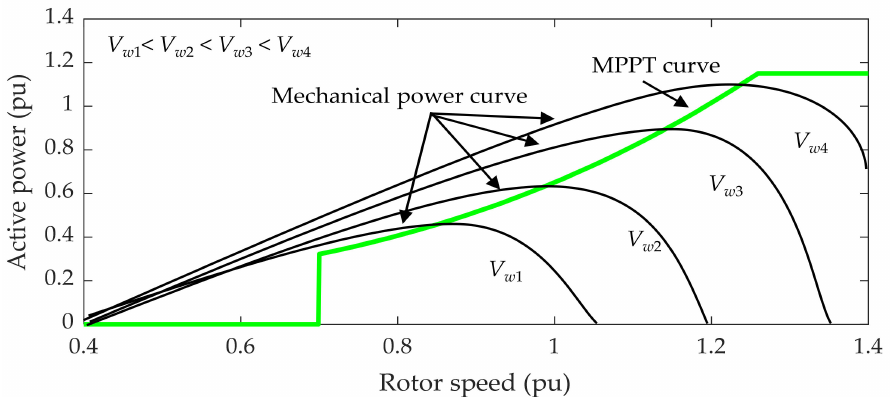
Figure 1. Operational characteristics of the MPPT control